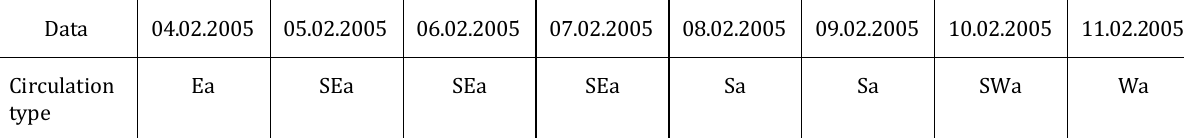
Table 1. The macrocirculation types of Niedźwiedź (1981) in analyzed days